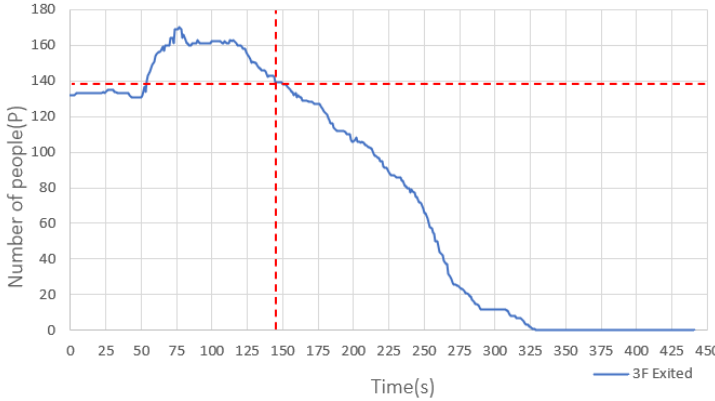
Figure 6. Front room of the escape ladder on the third floor at the 148th